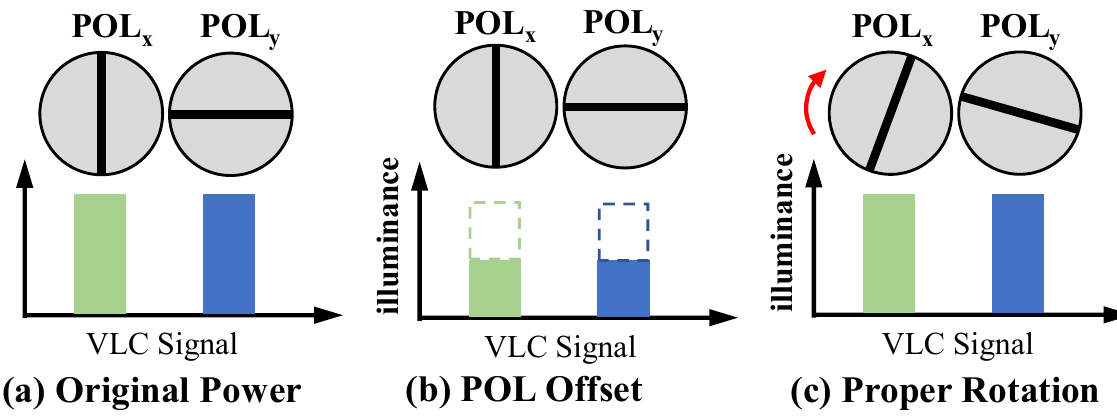
Figure 8. Obtained corresponding modulation rates of VLC (Green) and VLC (Green) within the FEC level under the different rotation angles from 0 ◦ to 50 ◦ .